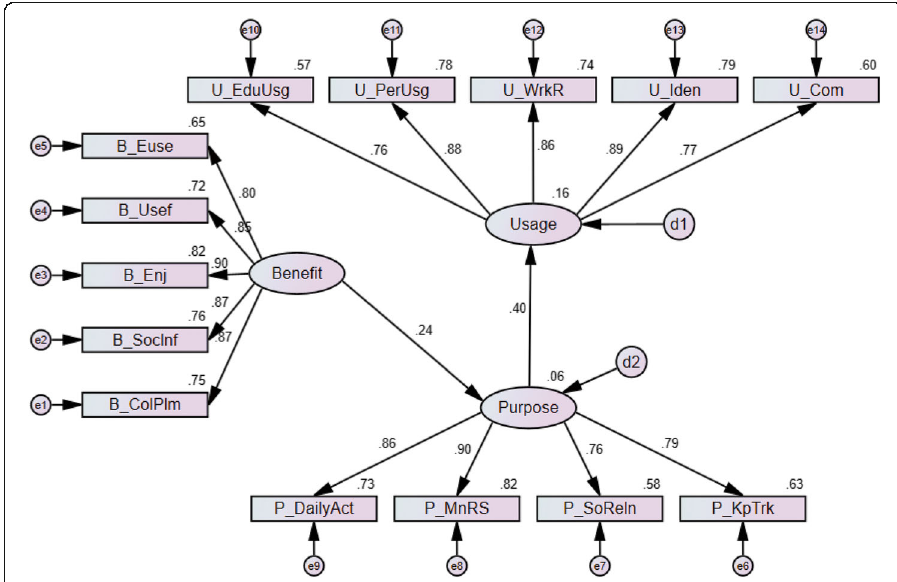
Fig. 3 The result of the proposed research model (unstandardized